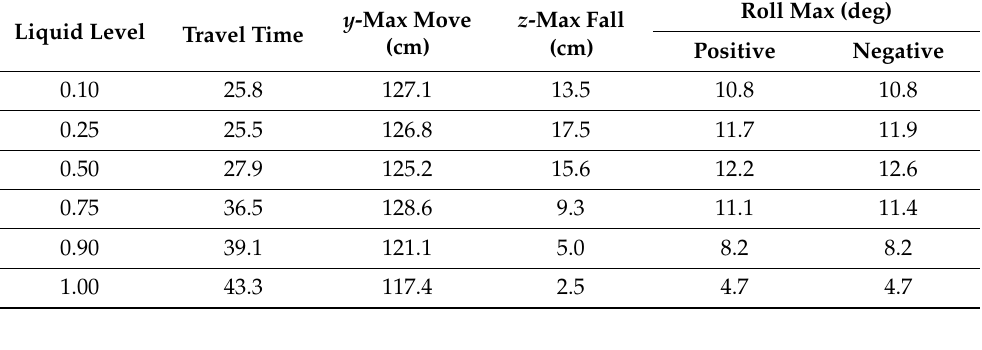
Table 4. Single-obstacle simulation result (ideal case).